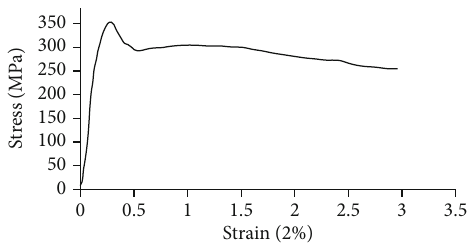
Figure 5: Stress vs. strain curve of spot-welded wire joints (rotational speed: 1400rpm and plunge depth: 1